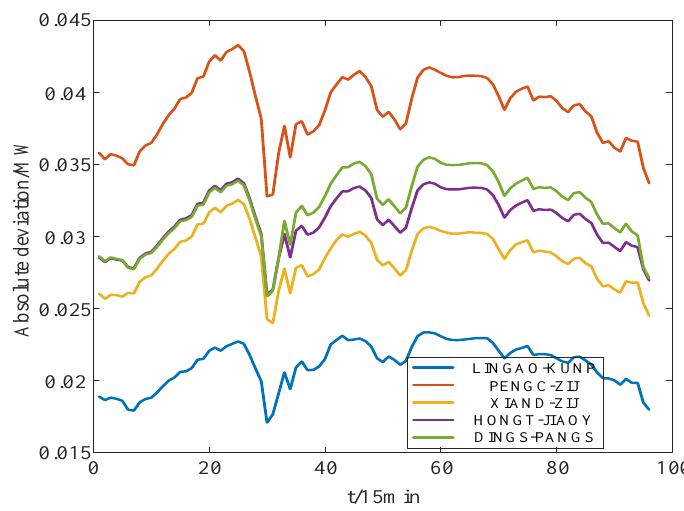
Figure 16. Absolute deviation of the two sides of quadratic equality (25) of several branches. Energies 2019 , 12 , x FOR PEER REVIEW Figure 17. The five maximum nodal active power mismatches of different buses.